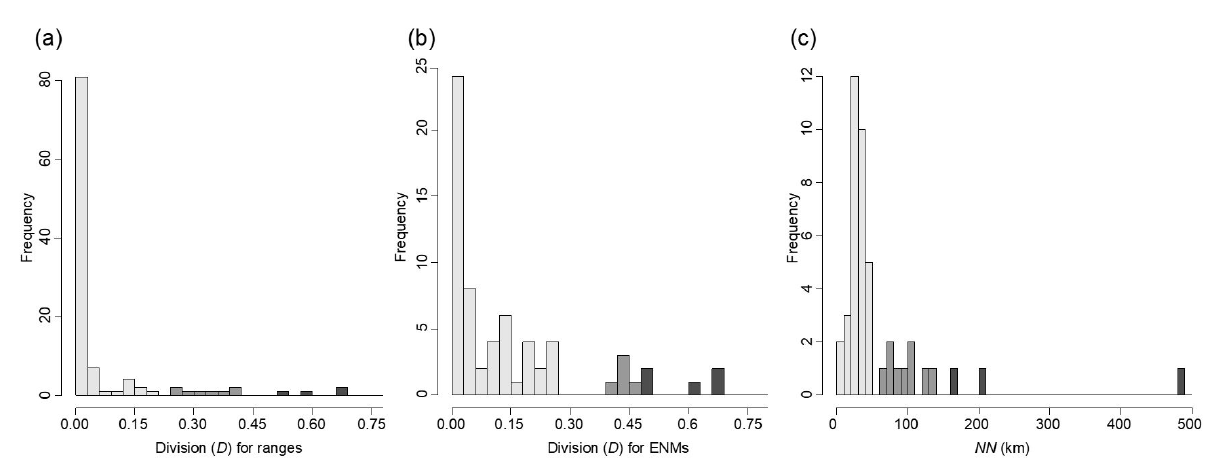
Figure 1. Histograms of D for (a) county-based ranges and (b) ENMs, and histogram of NN (c). Dark gray: high fragmentation (a, b) or distance (c), medium gray: moderate fragmentation (a, b) or distance (c), light gray: low/no fragmentation (a, b) or distance (c).